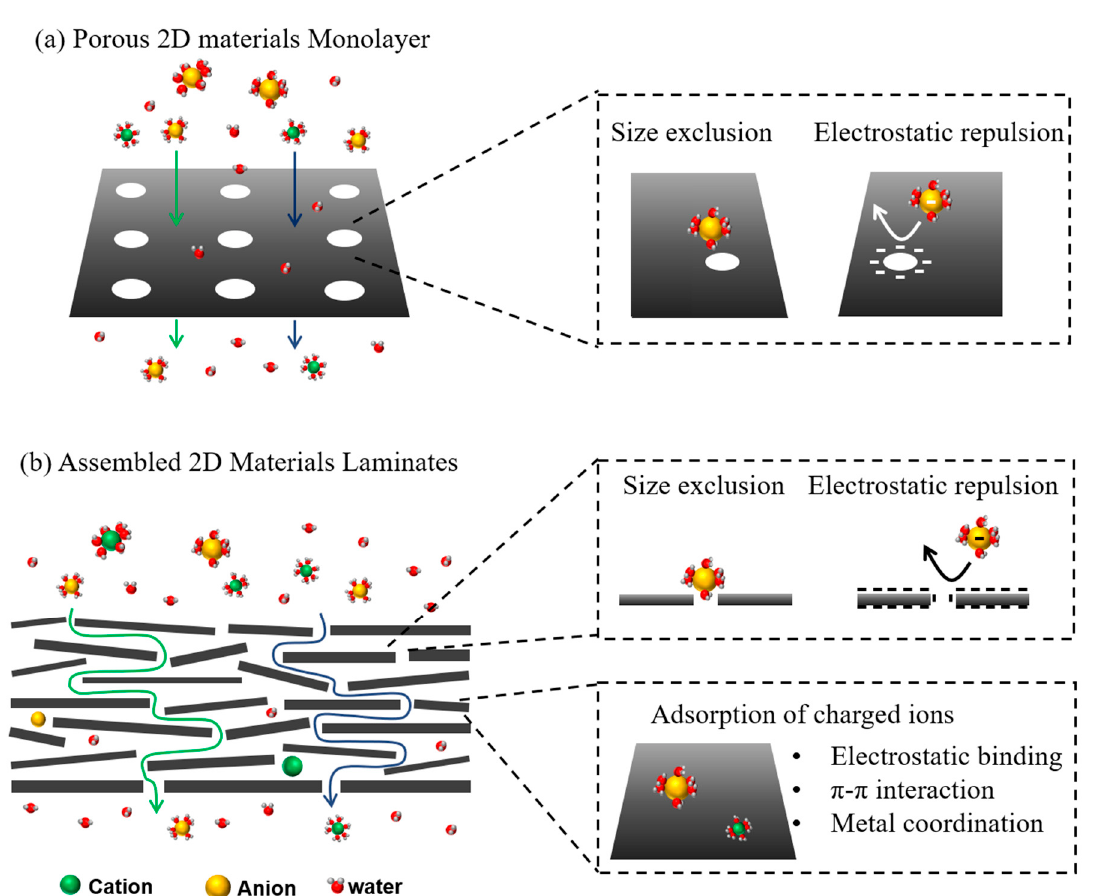
Figure 8. Schematic of the ionic transport mechanism of ( a ) a porous 2D material monolayer membrane consisting of nanopores of controlled pore size and ( b ) assembled 2D material laminates resulting from stacked 2D nanosheets. The separation mechanism relates to size exclusion (pore size) and electrostatic interactions between the charged pores and ions. The arrows illustrate the direction of water molecules and charged ions through the membranes.